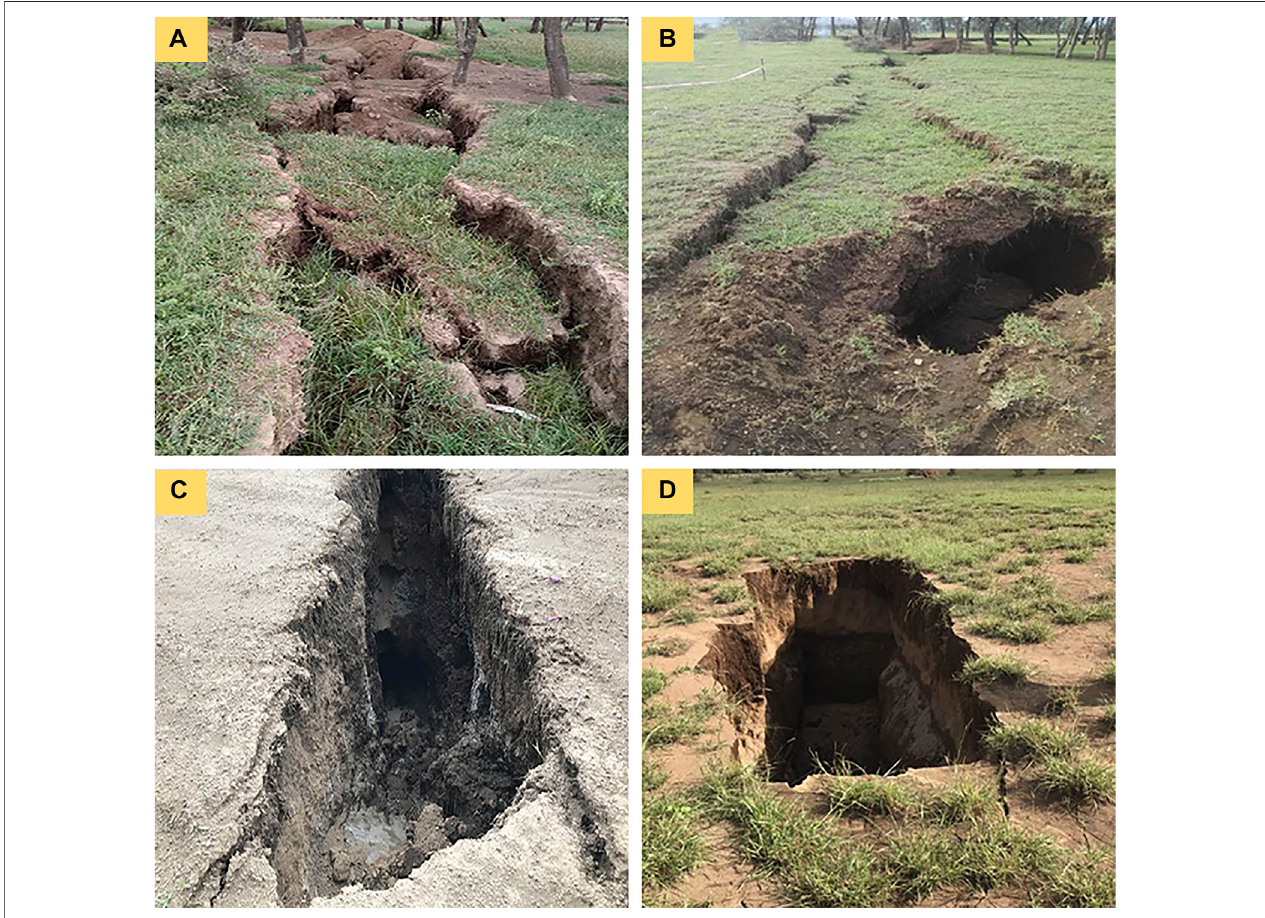
FIGURE 1 | Uneven settlement of the surface. (A) Surface uneven settlement with complete vegetation; (B) surface uneven settlement with holes; (C) collapsed hole; and (D) collapsed hole with the complete surrounding vegetation.